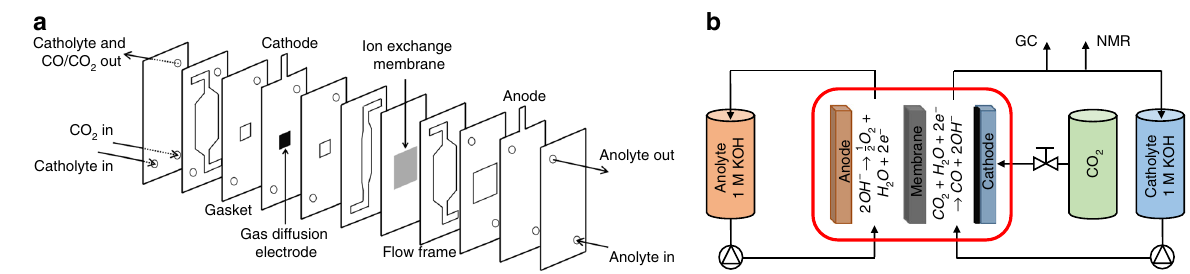
Fig. 4 Graphic illustration of the CO 2 electrolyzer fl ow cell. a Cross-sectional view of the cell and b general scheme of the entire experimental set-up